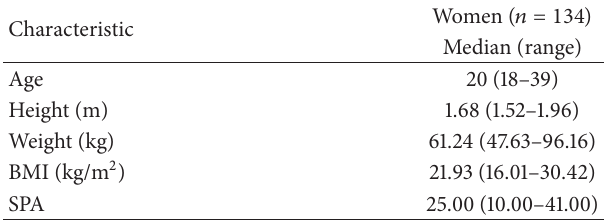
Table 1: Descriptive characteristics of students included in Study 1. Characteristic Age 20 (18–39)